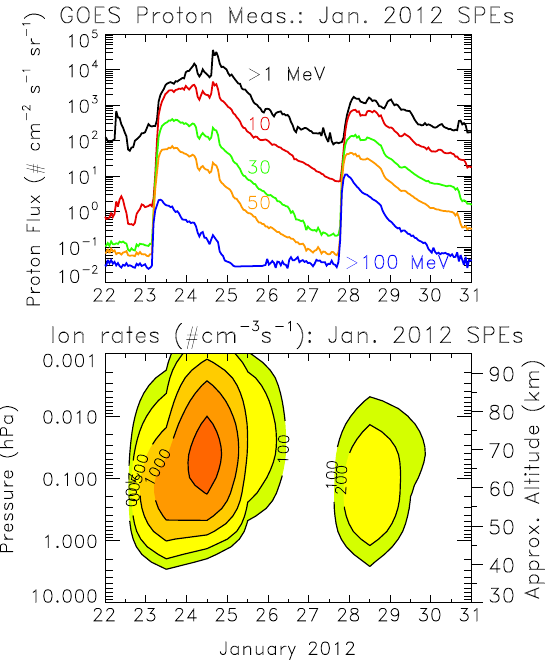
Fig. 1. ( Top ) GOES 13 proton flux measurements in January 2012 for energies >1MeV (black), >10MeV (red), >30MeV (green), >50MeV (gold), and >100MeV (blue). These data are provided by the NOAA SWPC at their website (see Sect. 2). ( Bottom ) Daily averaged ionization rates over the 10 to 0.001hPa pressure range for the 22–30 January 2012 time period. Contour intervals are 100, 200, 500, 1000, and 2000 (#cm − 3 s − 1 ) .